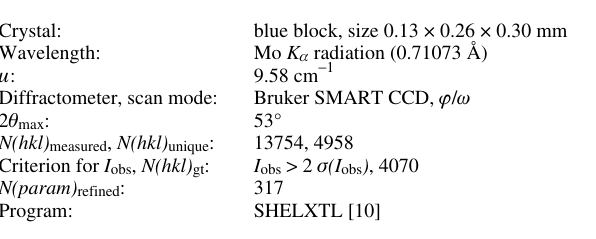
Table 1. Data collection and handling.